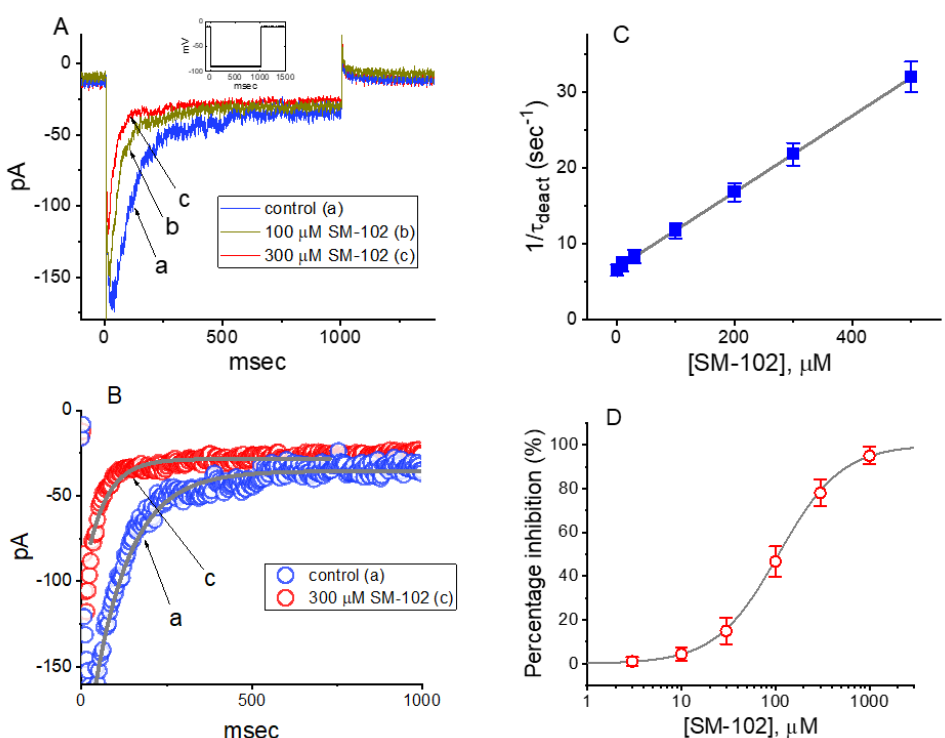
Figure 2. Effect of SM-102 on erg-mediated K + current (I K(erg) ) measured from pituitary tumor (GH 3 ) cells. This series of experiments were conducted in cells which were bathed in high-K + , Ca 2+ -free solution containing 1 μM TTX and 0.5 mM CdCl 2 , and we filled up the electrode by using K + -containing (145 mM) solution. ( A ) Representative I K(erg) traces obtained in the control period (i.e., SM-102 were not present; a) during cell exposure to 100 μM SM-102 (b) or 300 μM SM-102 (c). The voltage-clamp protocol applied is shown in inset. ( B ) Deactivation time courses of I K(erg) taken in the absence (a) and presence of 300 μM SM-102 (c). The current trajectory (i.e., traces a and c) taken